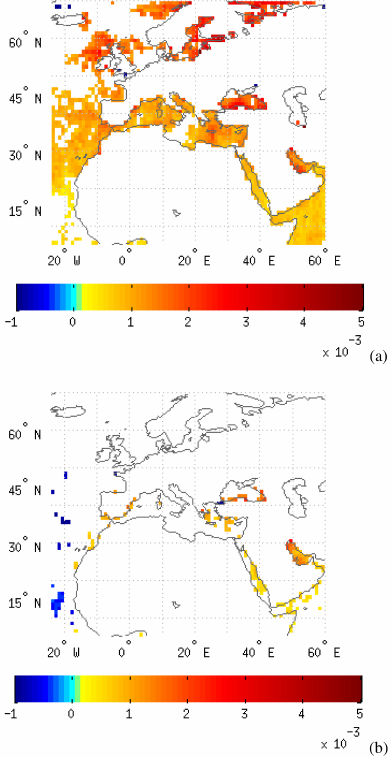
Figure 5. Slope (in units decade − 1 ) of MODIS g aer de- seasonalized anomalies over the period 2002-2010 from MODIS- Terra ( -a , top) and MODIS-Aqua ( -b , bottom), for the wavelengths of 470nm. Results are shown only if the trend is statistically signif- icant at the 95% confidence